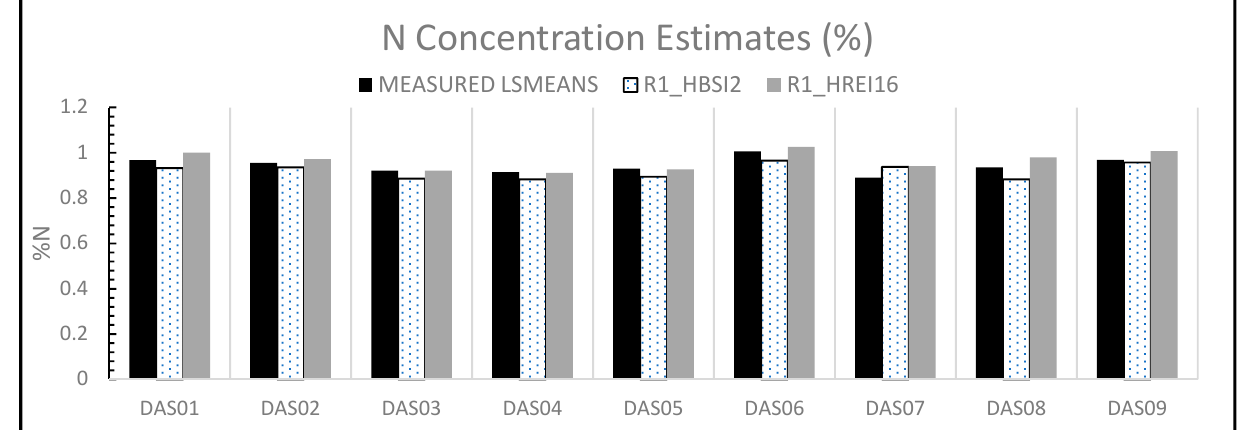
Figure 3. Least square means estimates of N concentration (pN) (%) by hybrid for the ground refer- ence model, HBSI2 and HREI16 at R1 models.